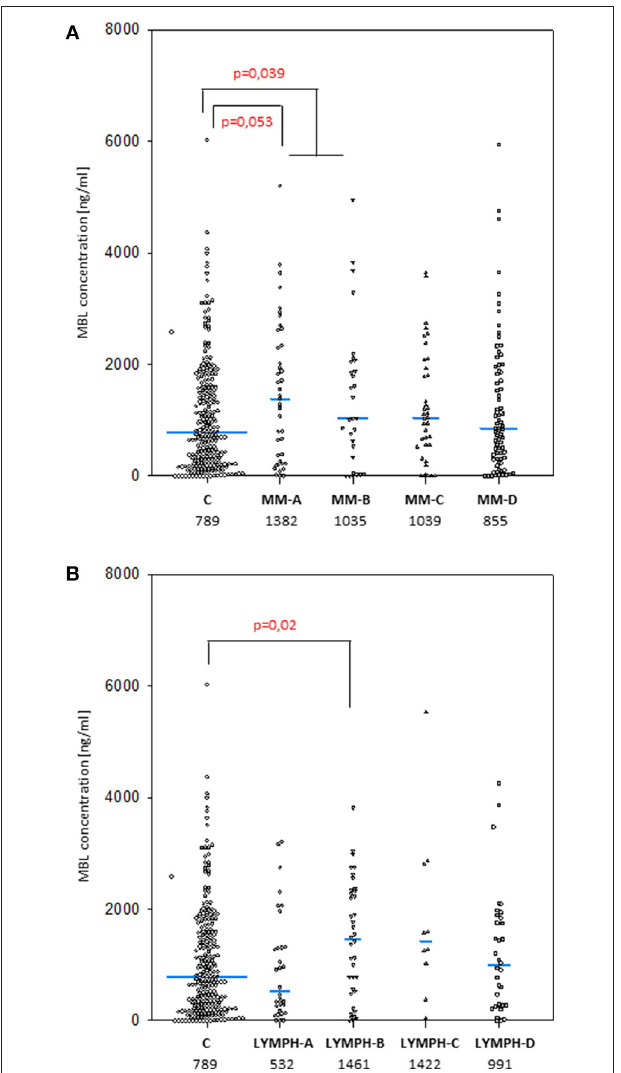
FIGURE 1 | Mannose-binding lectin serum concentrations in patients (before conditioning chemotherapy) and controls. Blue bars present median values (given below group descriptions). (A) controls (C) vs. multiple myeloma (MM) patients; (B) controls vs. lymphoma (LYMPH) patients. MM-A, LYMPH-A: patients who experienced infections with proven bacteremia; MM-B, LYMPH-B: patients who experienced infections with no bacteremia; MM-C, LYMPH-C: patients who experienced febrile neutropenia; MM-D, LYMPH-D: patients who experienced none of afore-mentioned complications during hospital